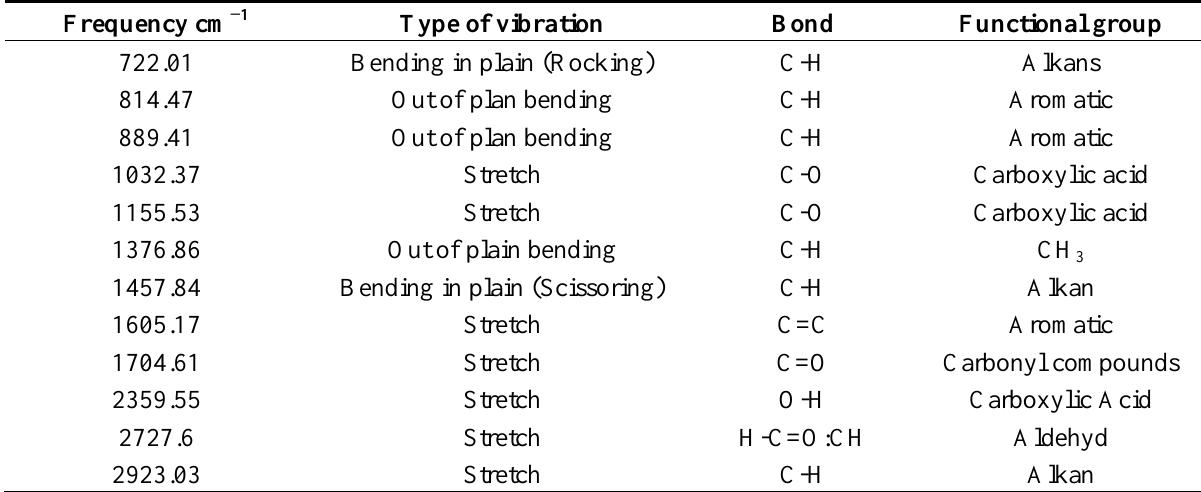
Table 9. Results of analysis of the used engine